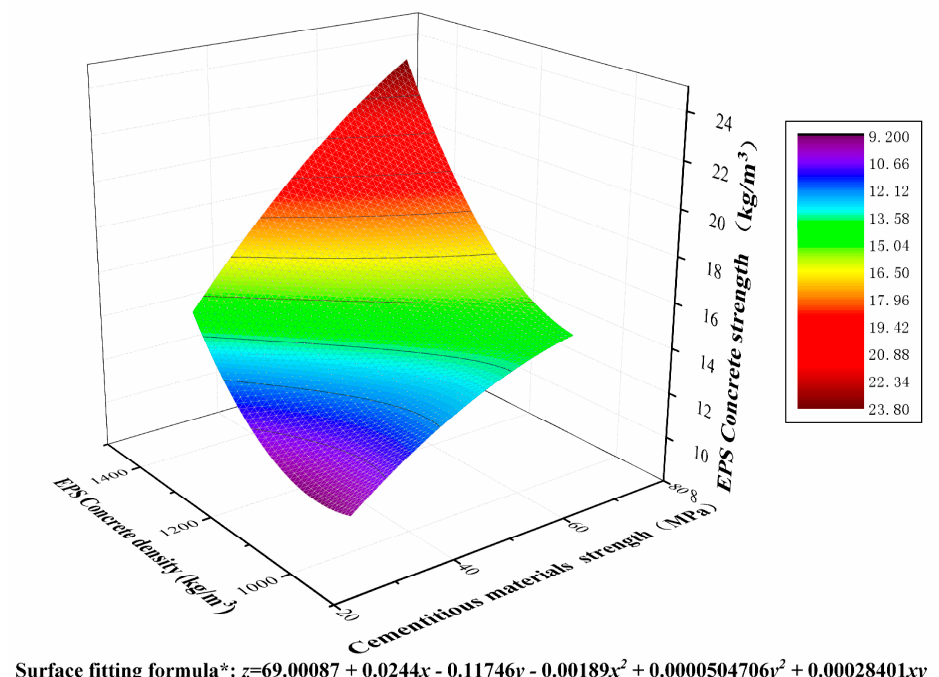
Figure 6. Fitting curve for paste strength and EPS-concrete